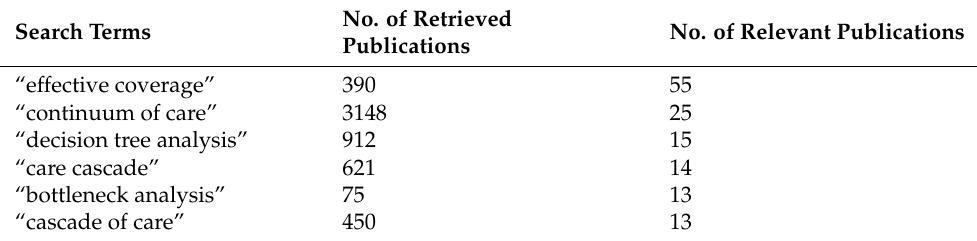
Table 1. Search strategy and